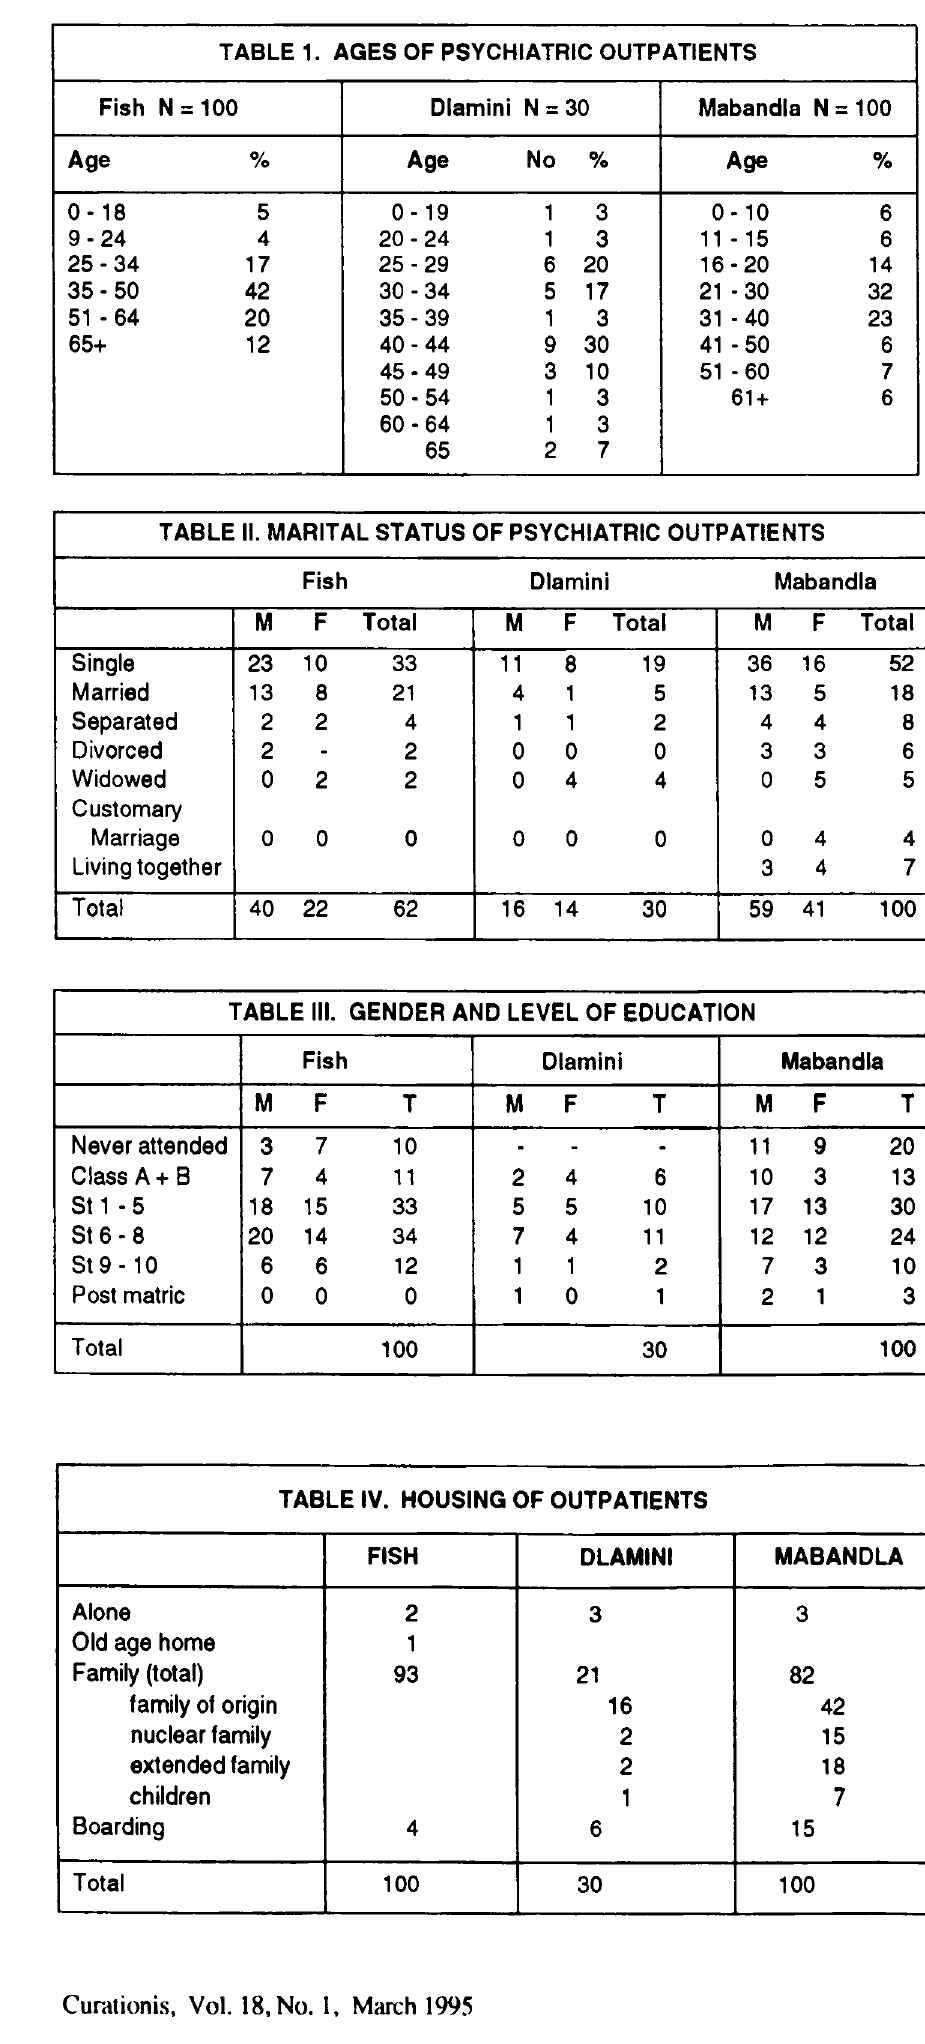
TABLE 1. AGES OF PSYCHIATRIC OUTPATIENTS